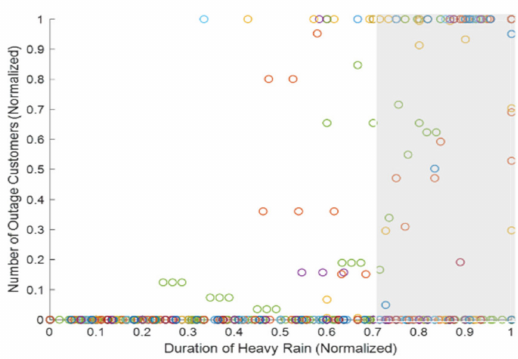
Figure 1. Number of outage customers for heavy rain